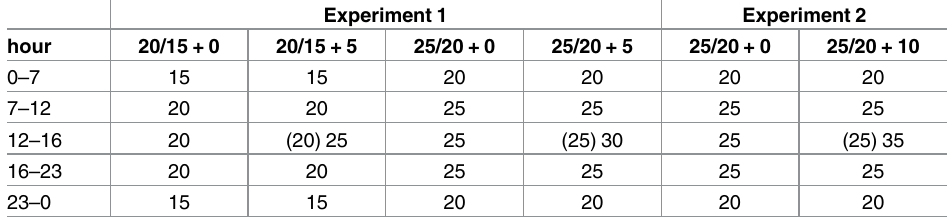
Table 1. Temperature settings over a day for the different thermal regimes applied in experiments 1 and 2.